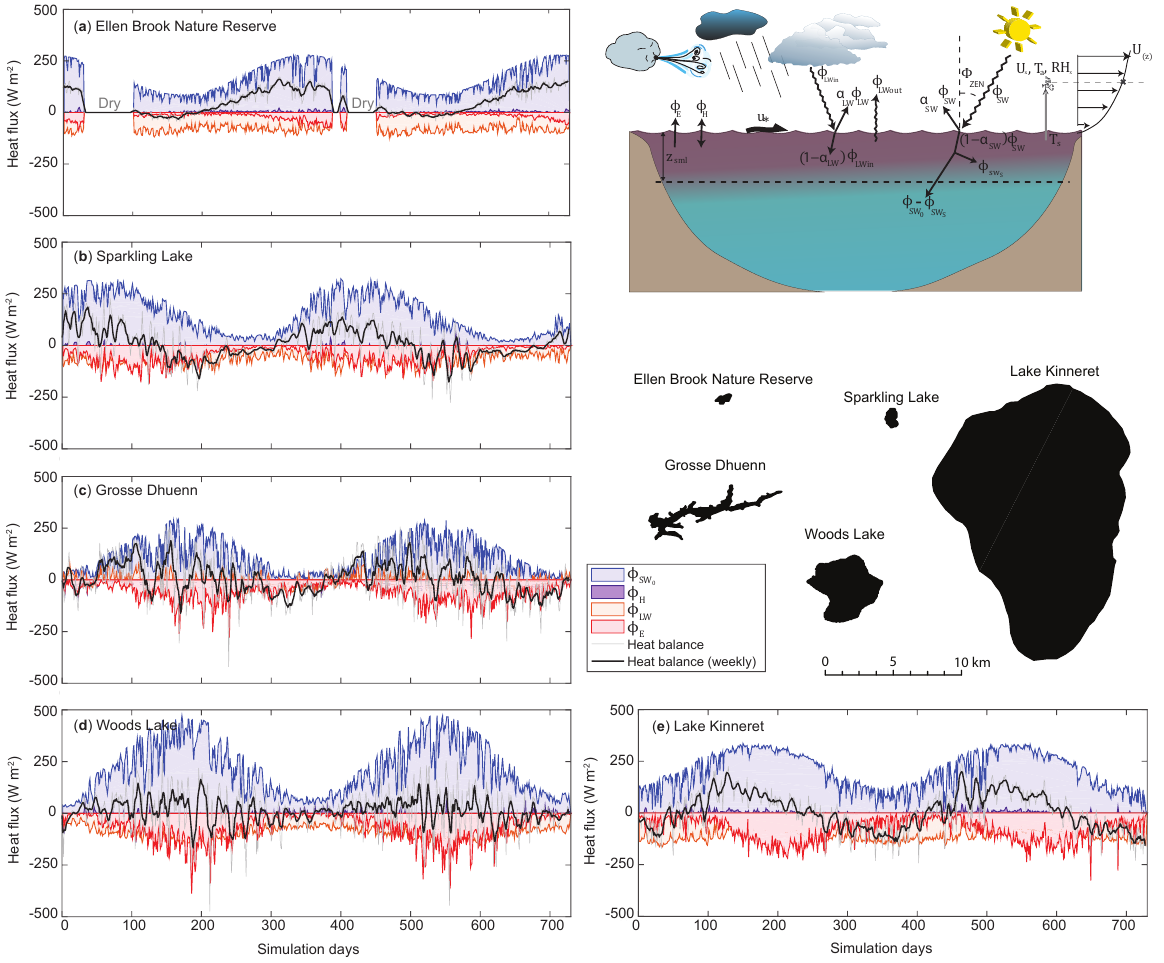
Figure 5. A 2-year times series of the simulated daily heat fluxes for the five example lakes (a–e) that were depicted in Fig. 2. The heat balance components summarized are depicted schematically in the inset, as described in Sect. 2.3, and the “heat balance” line refers to the LHS of Eq.